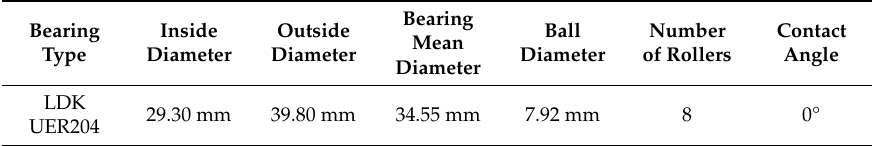
Table 1. Tested bearing